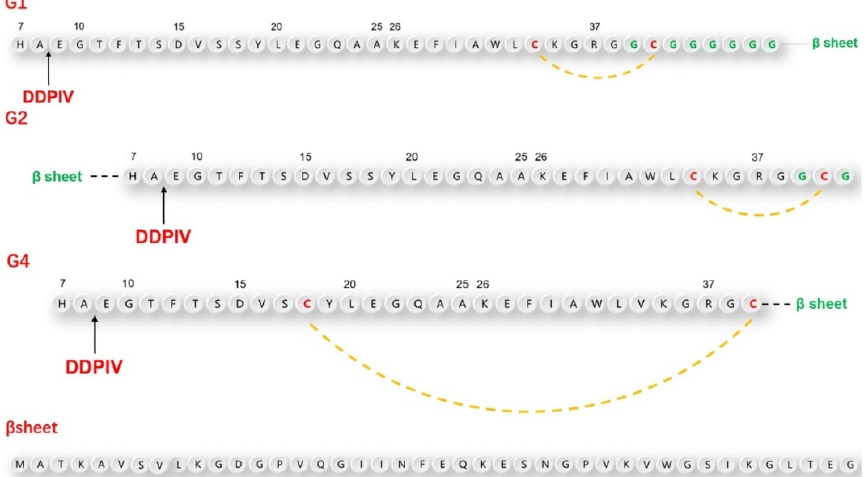
Figure 1. Sequences of GLP-1Rs (G1, G2, G4), β sheet is the antiparallel β lamellar domain added on N-terminal or